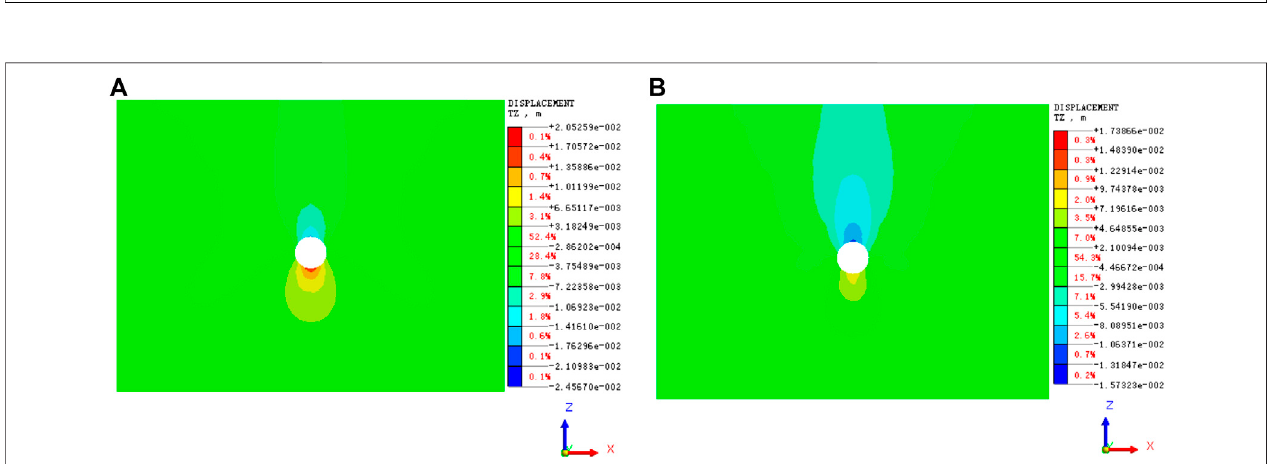
FIGURE13| SectionII-IIdeformationcloudofsurroundingrockunderdifferentconditions. (A) CloudmapofsurroundingrockunderCondition1. (B) Cloudmapof surrounding rock under Condition 2.